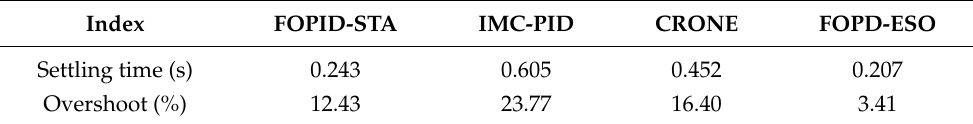
Table 5. Step response performance indices of the systems.